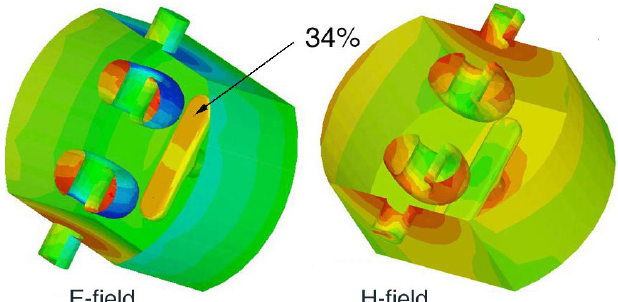
FIG. 5. (Color) Distribution of E -field and H -field at a RT, mode and H=H as a percentage. In 2. Numbers display ratios E=E p p the left picture, E=E , blue signifies negative charge and red p , positive charge. In the right picture, red corresponds to high p H -field, green to low